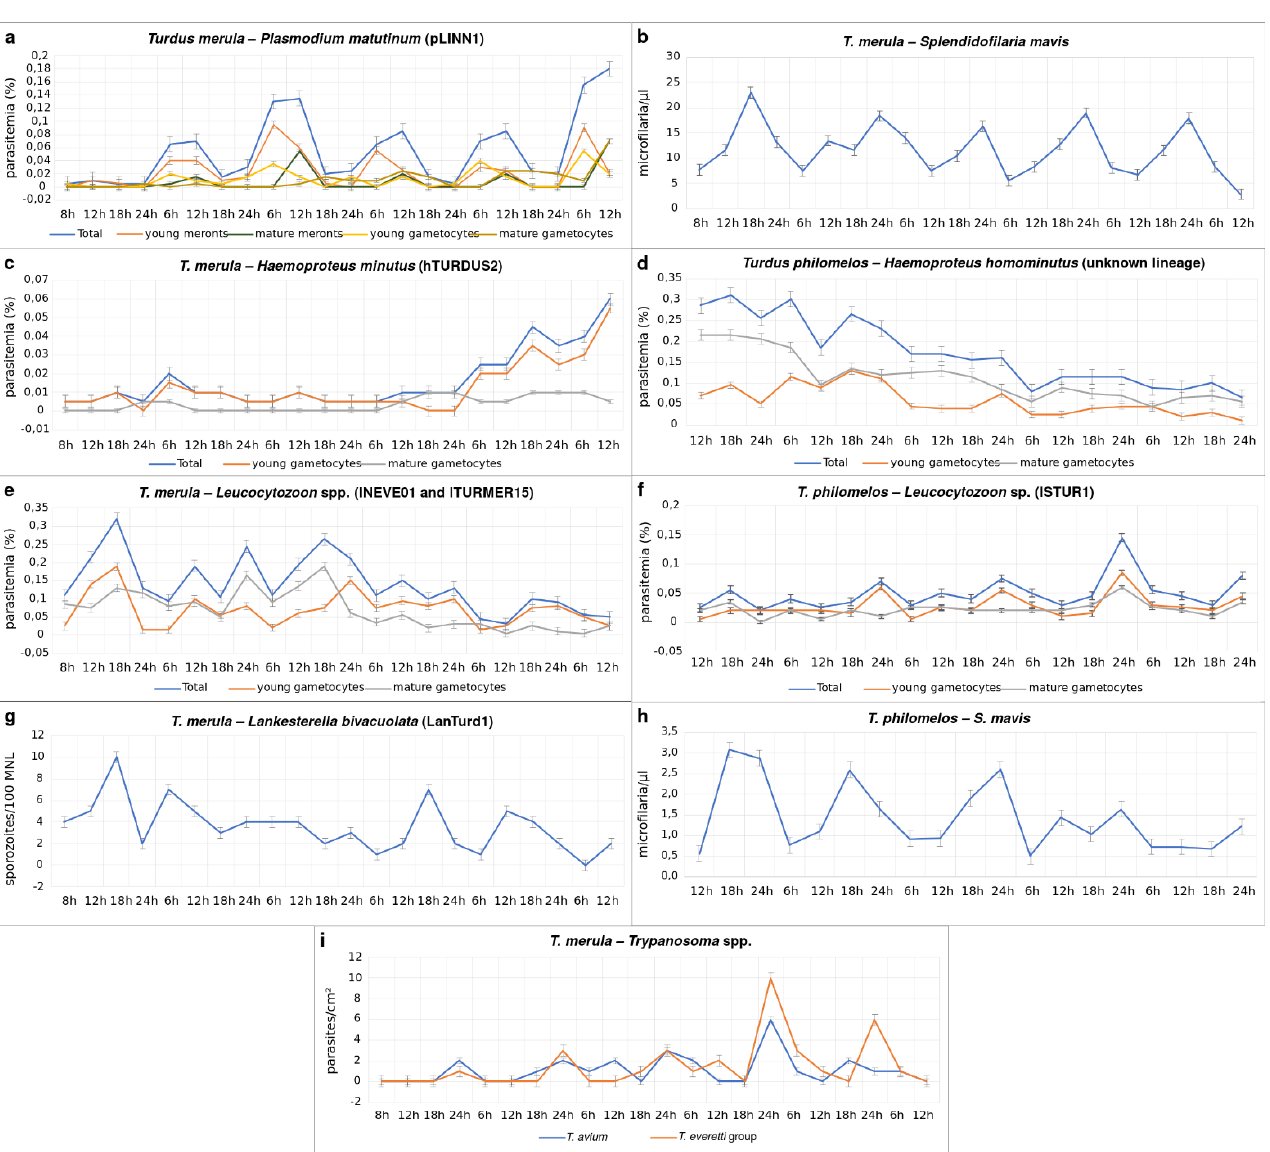
Figure 6. Circadian rhythms of parasites infecting a Eurasian blackbird ( Turdus merula ) ( a – c , e , g , i ) and a Song thrush ( Turdus philomelos ) ( d , f , h ). Plasmodium matutinum (cytochrome b lineage pLINN1) ( a ), Haemoproteus minutus (hTURDUS2) ( c ), Haemoproteus homominutus (unknown lineage) ( d ), Leucocytozoon sp. (co-infection of lNEVE01 and lTURMER15) ( e ), Leucocytozoon sp. (lSTUR1) ( f ), Lankesterella bivacuolata n. sp. (18S rRNA lineage LanTurd1) ( g ), Trypanosoma avium and Trypanosoma everetti group ( i ), and Splendidofilaria mavis ( b , h ). Intensity of parasitemia and day hours of the blood sampling were indicated on the ordinate and abscissa, respectively. Vertical bars indicate standard errors.